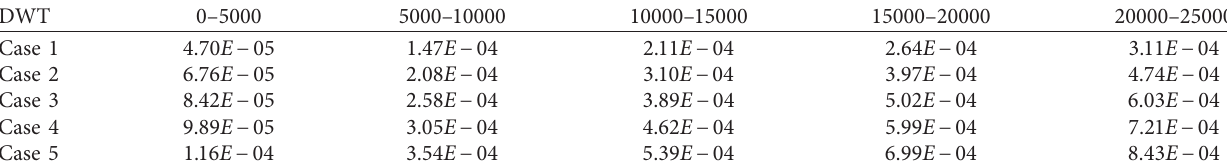
Table 6: Dynamic response of main tower (Rad).